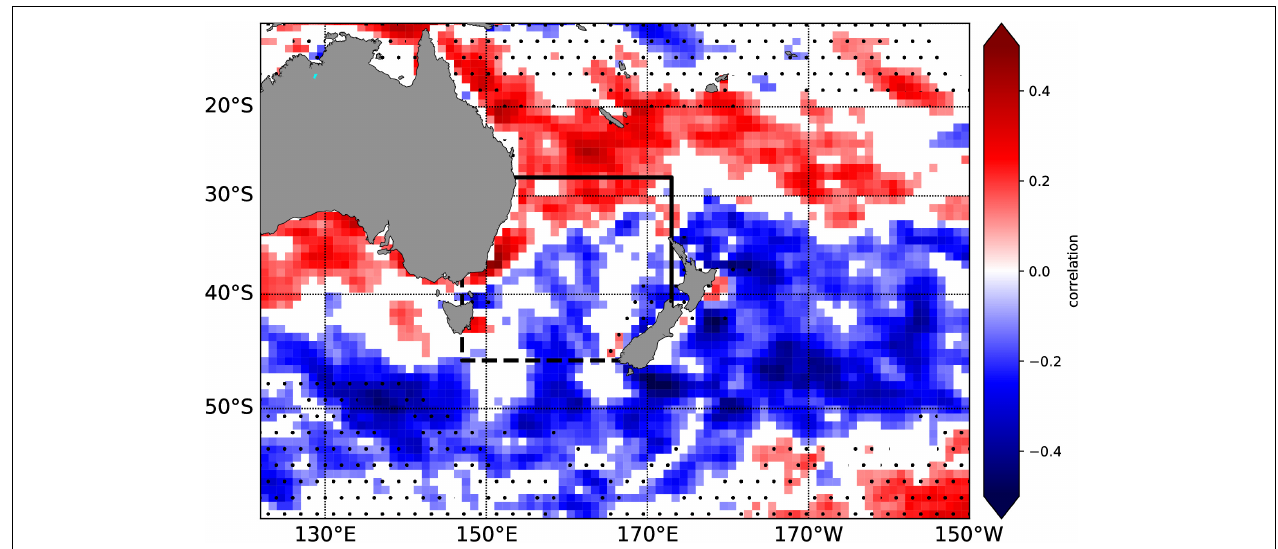
FIGURE 8 | Correlation between Tasman North heat transport and wind stress curl over the period 1970 to 2017 (interannually filtered). Only significant correlations above the 95% confidence level are shown. The dots indicate regions with a negative mean wind stress curl. The Tasman Box is shown by the black lines. The Tasman North section is marked by the solid black line and Tasman South by the dashed black line.